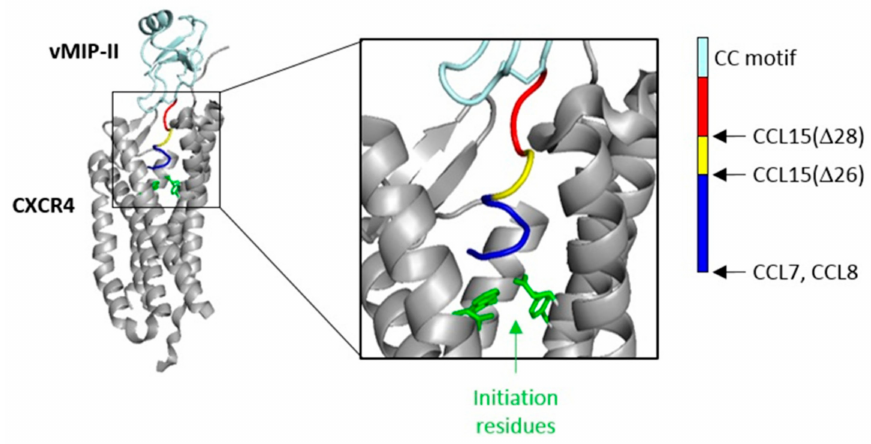
Figure 5. Position of chemokine N-terminal region in the receptor-binding pocket. Full ( left ) and zoom-in ( center ) views of the structure (PDB code: 4RWS) of the complex between CXCR4 (gray ribbons; side chains of signal initiation residues shown as green sticks) and vMIP-II (light cyan ribbons with disulfides as sticks; N-terminal region highlighted in: blue, residues 1–5; yellow, residues 6, 7; and red, residues 8–10). ( Right ) Bar showing the relative lengths of the N-terminal regions for CCR1 cognate chemokines described in this